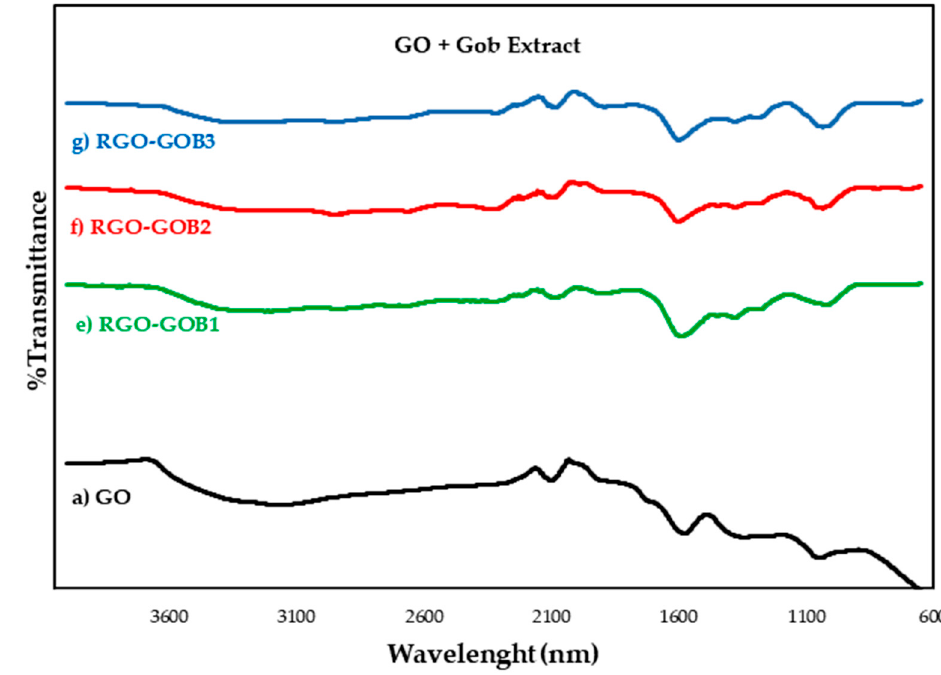
Figure 7. FT-IR transmittance spectrum of graphene oxide (GO) and reduced graphene oxide (RGO) samples with natural extracts. The analyzed samples are (a) GO (unreduced), (e) RGO-GOB1 5% (f) RGO-GOB2 10%, (g) RGO-GOB3 20%.